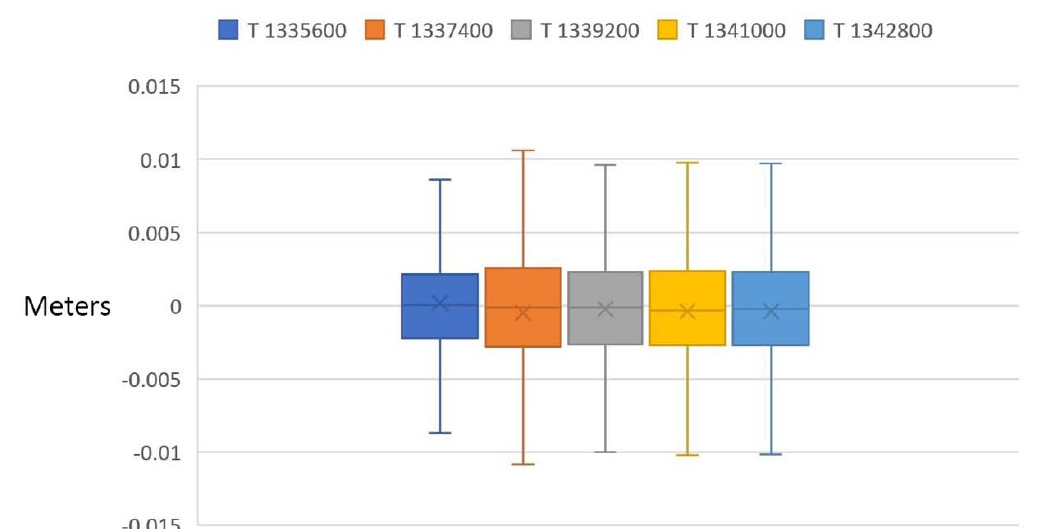
Figure 9. Variation in sea surface for nearest adjacent nodes for timesteps during maximum storm surge of Hurricane Rhody in the Fields Point area of the Port of Providence. Where variations are so small, interpolation between nodes may not be necessary. Image: Authors.